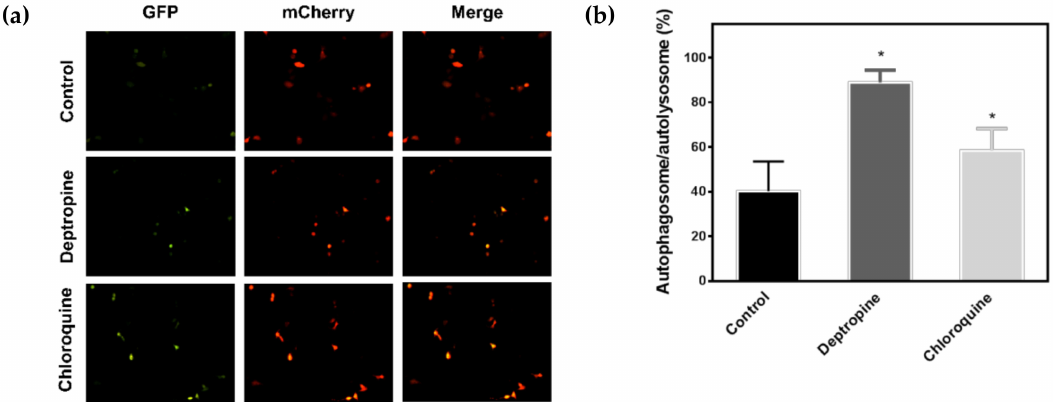
Figure 4. E ff ects of deptropine on inhibition of autophagosome-lysosome fusion in human hepatoma cells. Hep3B cells were transfected with the FUW mCherry-green fluorescent protein (GFP)-LC3 plasmid and then treated with 20 µ M of deptropine for 24 h. Autophagosomes / autolysosomes were visualized with fluorescence microscopy. Chloroquine (25 µ M) was used as a positive control. ( a ) Representative fluorescence images are shown, and ( b ) autophagic flux was estimated as the ratio between yellow-positive cells and red-positive cells, which are presented as the mean ± standard error. * p < 0.0001.